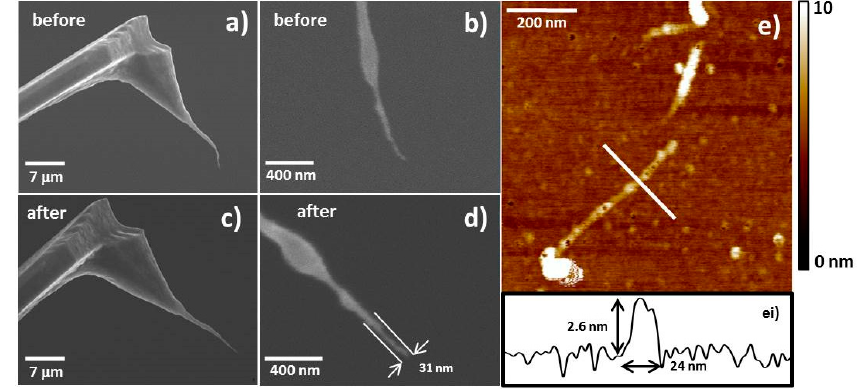
Figure 8. SEM images of tip 2 before processing ( a , b ) and after processing ( c , d ). Figure 8e is an AFM image of a CNT on a CNT covered silicon surface using tip 2 after processing with Figure 8ei showing a cross section which corresponds to the white line in Figure 8e. Comparing the before and after SEM images indicates there has been a significant amount of straightening of the CNT